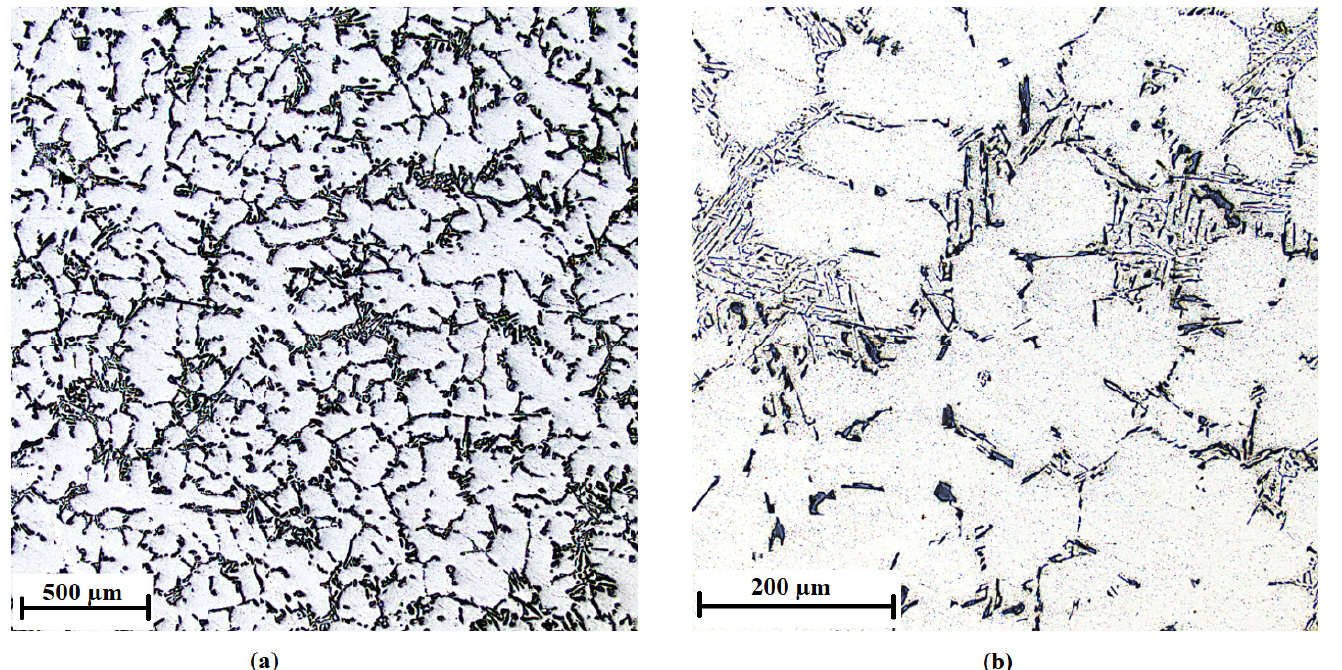
Figure 11. Microstructure of the AlSi7Mg0.3 alloy with the addition of 0.01 wt % AlTi5B1: ( a ) low- magnification overview, ( b ) detail.